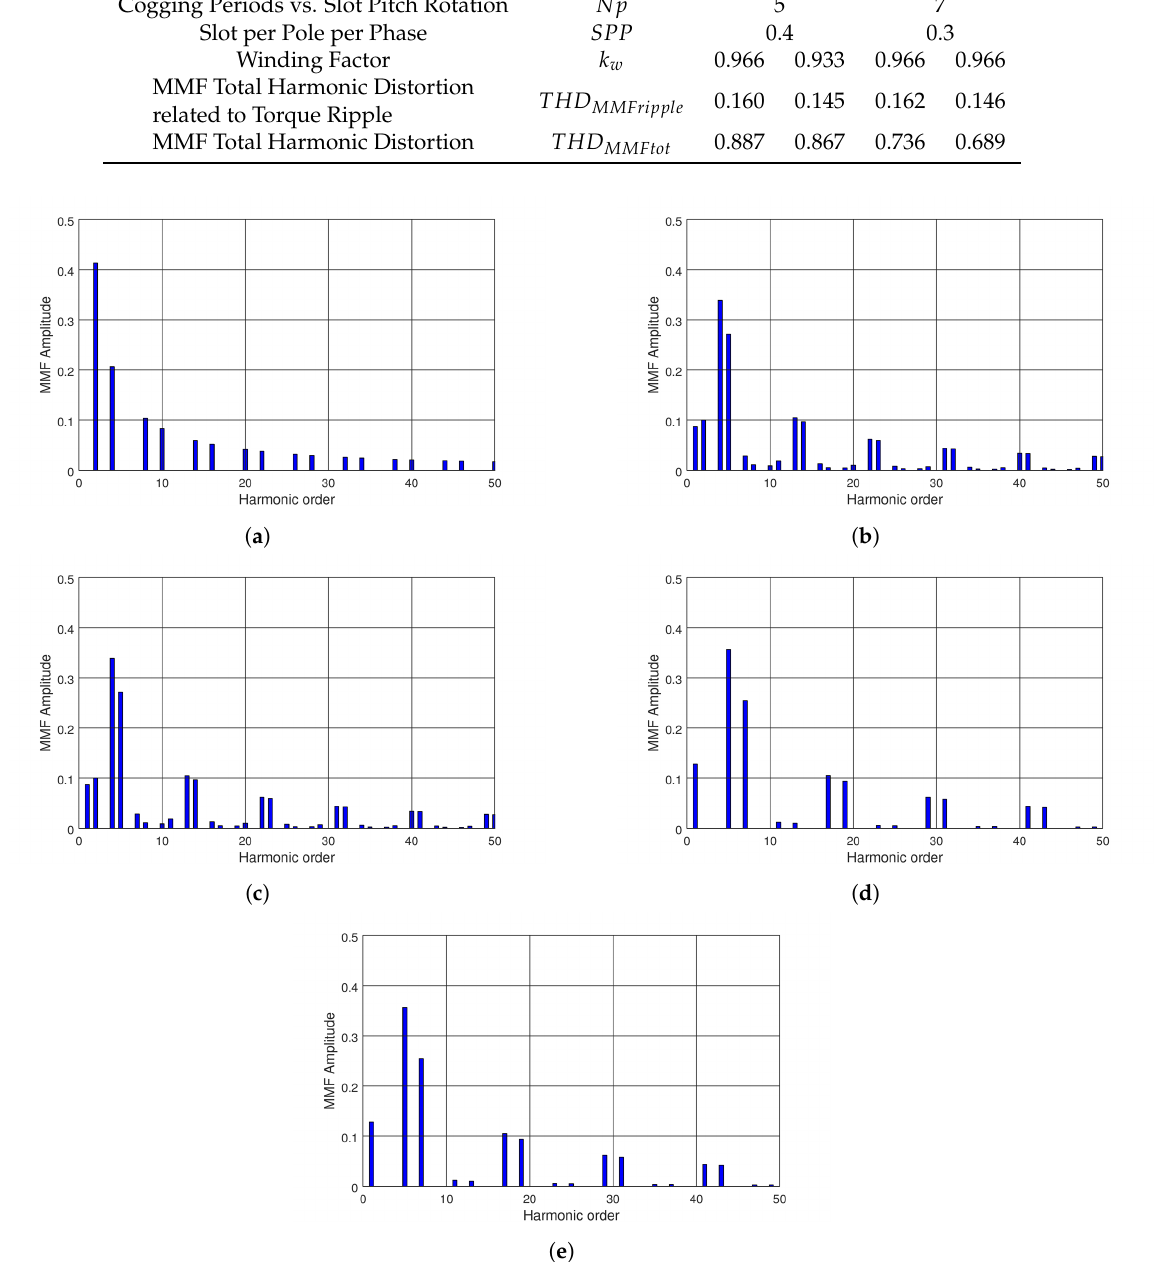
Figure 1. Magneto-Motive Flux (MMF) spectra for different double layer slot–pole combinations: ( a ) MMF of 6-4DL; ( b ) MMF of 9-8DL; ( c ) MMF of 9-10DL; ( d ) MMF of 12-10DL; and ( e ) MMF of